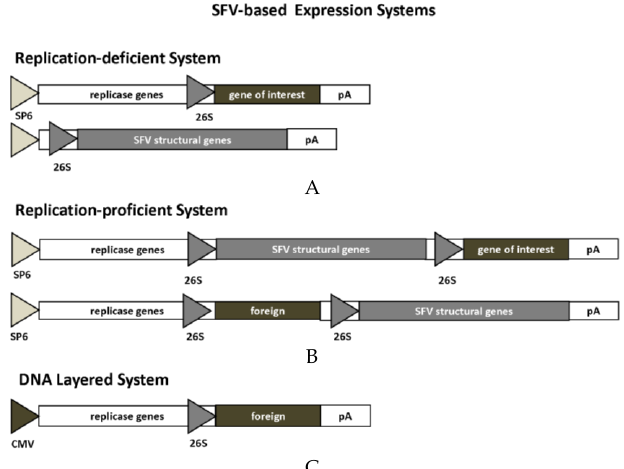
Figure 1. SFV-Based Expression Systems. ( A ) Replication-deficient system. In vitro transcribed RNA from expression and helper vectors are transfected into BHK-21 cells for generation of replication-deficient particles; ( B ) Replication-proficient system. In vitro transcribed RNA from full-length vector is transfected into BHK-21 cells for generation of replication-proficient particles; ( C ) DNA layered system. Plasmid DNA is transfected into host cells. 26S, SFV26S subgenomic promoter; CMV, cytomegalovirus promoter; pA, polyadenylation signal; SP6, SP6 phage RNA polymerase promoter.